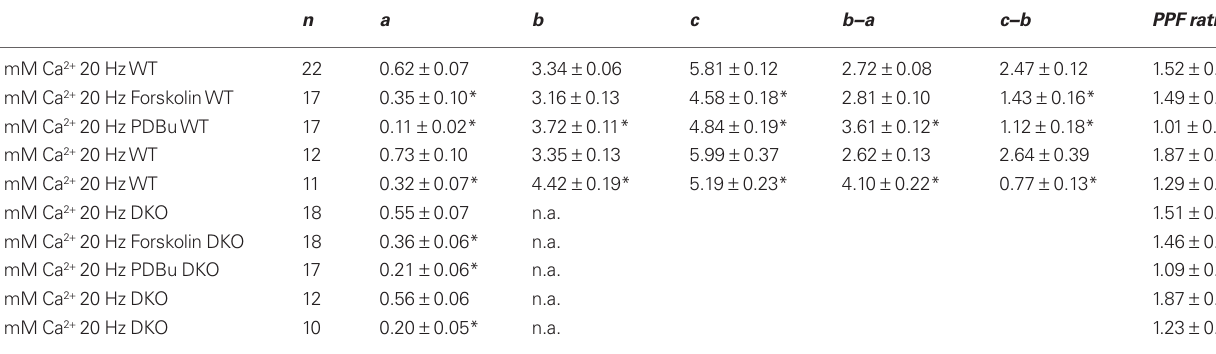
Time needed from stimulus initiation to reach: a, the peak magnitude of the initial frequency facilitation; b, the transition point between the initial frequency facili- tation and DRE; and c, peak of the DRE, respectively. Subtractions (b − a) and (c − b) indicate the durations of the decaying phase of the initial frequency facilitation and the ascending part of the DRE phase, respectively. PPF ratio: pooled paired-pulse facilitation ratios (see Materials and Methods). Experiments were performed under the conditions indicated, and the results represents seconds (mean ± S.E.M., derived from n experiments). *p < 0.05, compared to the standard conditions (2 mM Ca 2 + , 20 Hz, 29 ° C) in the corresponding genotypes. n.a., not applicable. Time (s) ± S.E.